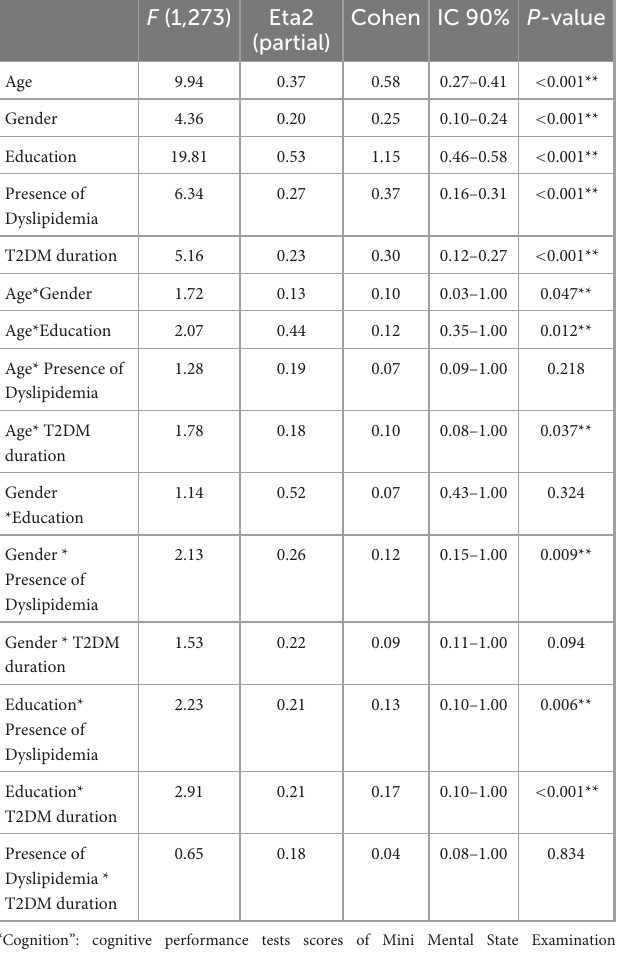
TABLE 6 Cognitive performance assessments scores of the participants comparing people without and with Type 2 Diabetes Mellitus.